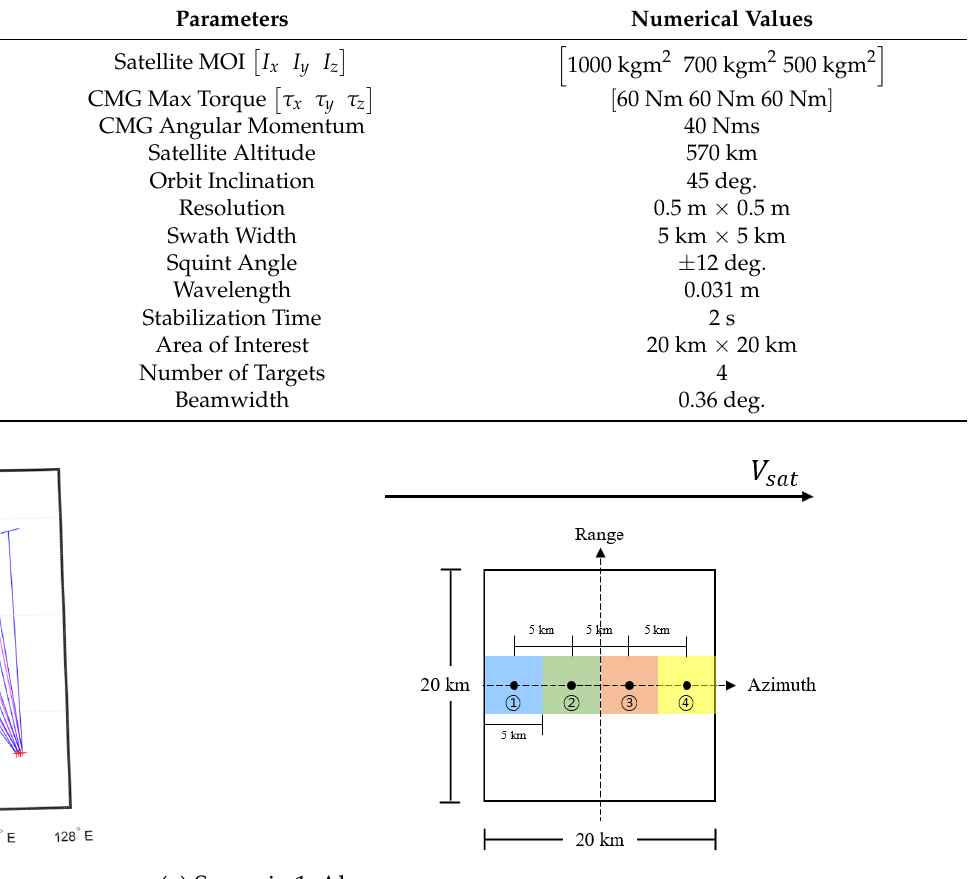
Table 2. Simulation parameters.